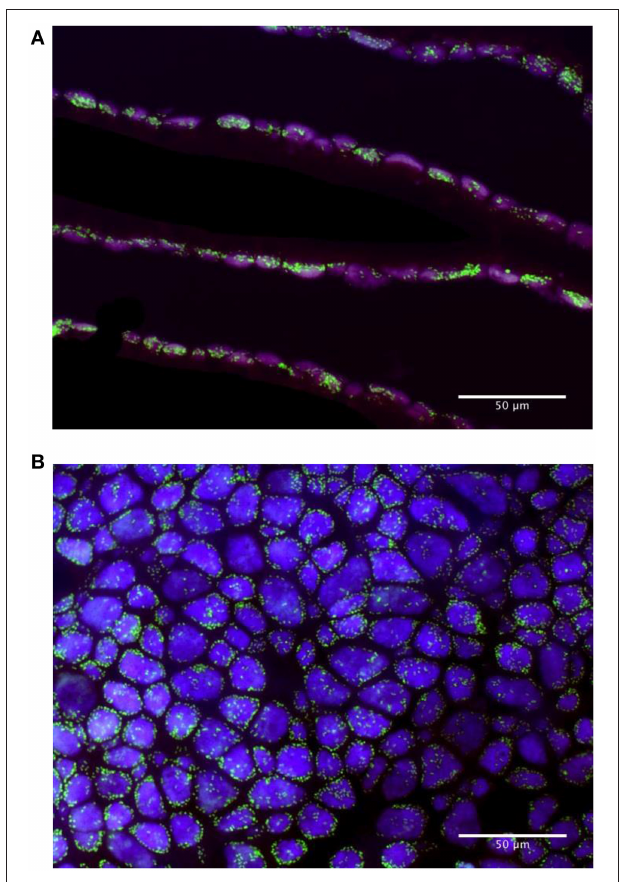
FIGURE 2 | (A) Fluorescence in situ hybridization on transverse sections of gill filaments used for FISH estimation of symbiont relative abundances; (B) FISH on the apical surface of whole filaments spread on a slide, used for estimation of bacteriocyte densities. Sulfur-oxidizers, labeled with the BangT-642 probe appear in purple, methane-oxidizers labeled with probe ImedM-138 appear in